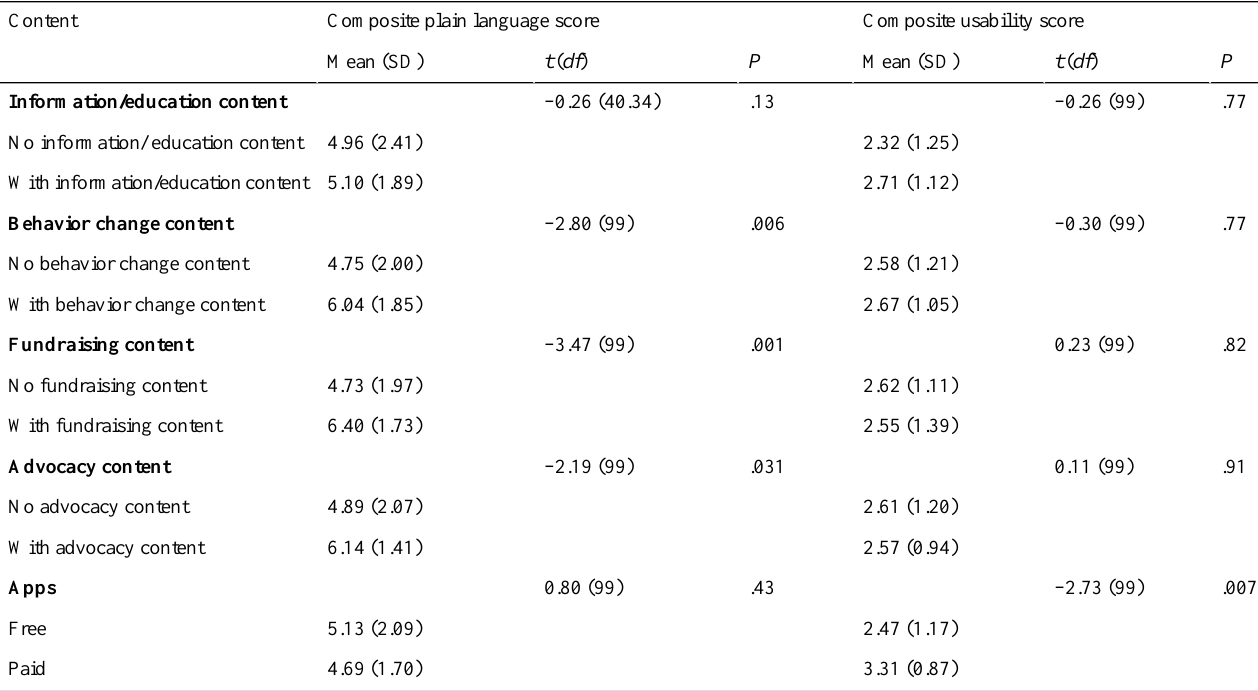
Table 3. Adherence of apps to literate principles (N=101).